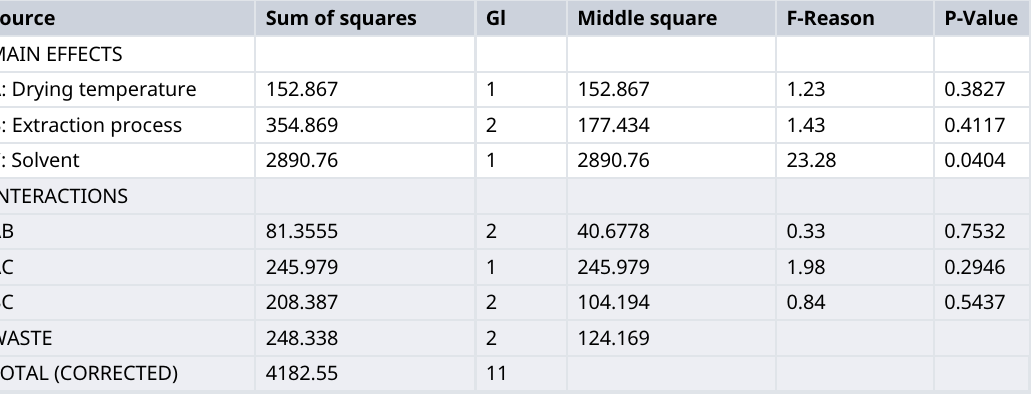
Table 2. Analysis of variance for extraction yields of Bidens pilosa L.